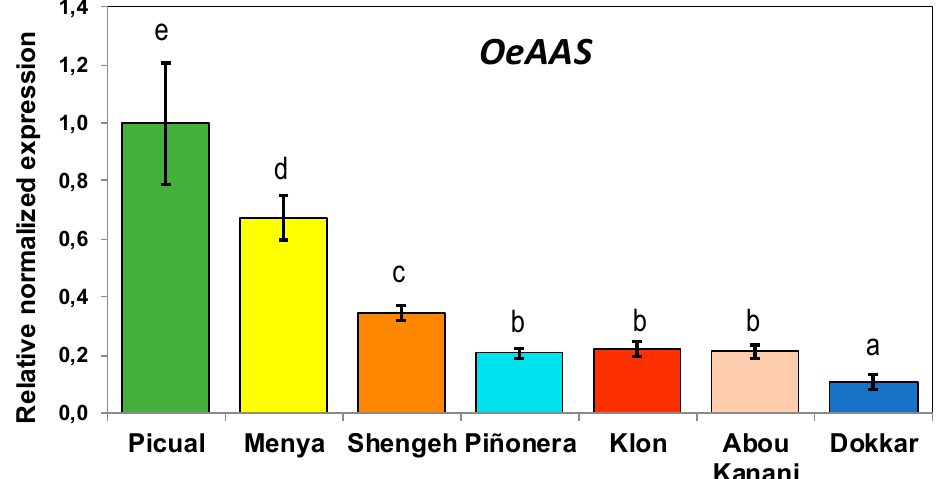
Figure 4. Relative expression levels of olive AAS gene in the mesocarp tissue of Picual, Menya, Shengeh, Piñonera, Klon, Abou kanani, and Dokkar fruits harvested at the commercial maturity stage for olive oil extraction (stage III). Data are mean ± SD. Three biological and two technical replicates were obtained for each sample. Different letters indicate statistically significant differences according to Tukey’s test ( p ≤ 0.05).